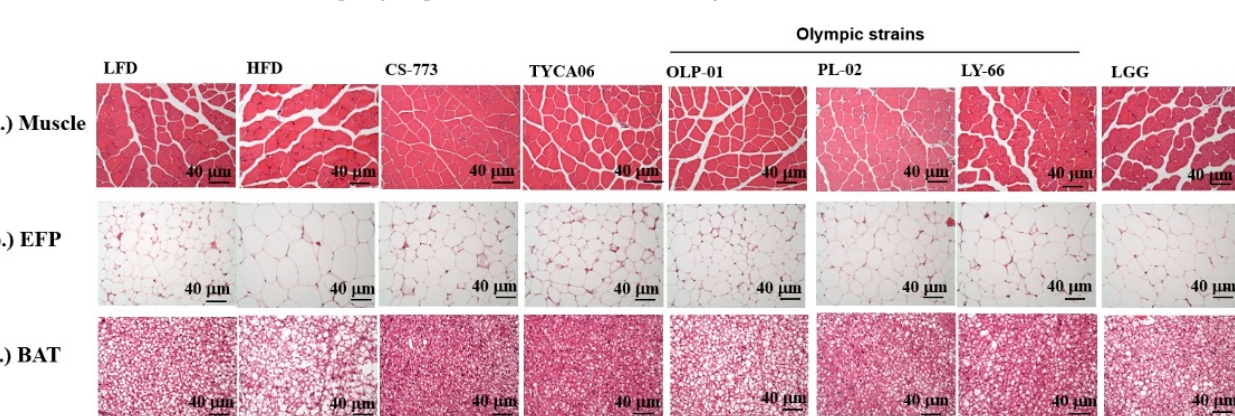
Figure 1. Effects of 10 weeks of probiotic supplementation on ( a ) relative grip strength, ( b ) exhaustive running duration, ( c ) body weight, and ( d ) fat body mass compared with a high-fat diet control group. # p < 0.05, ## p < 0.01, ### p < 0.001 compared with a high-fat diet control group. * p < 0.05, ** p < 0.01, *** p < 0.001 compared with the low-fat diet group. Data are expressed as mean ± SD for n = 8 mice per group. LFD, low-fat diet; HFD, high-fat diet.